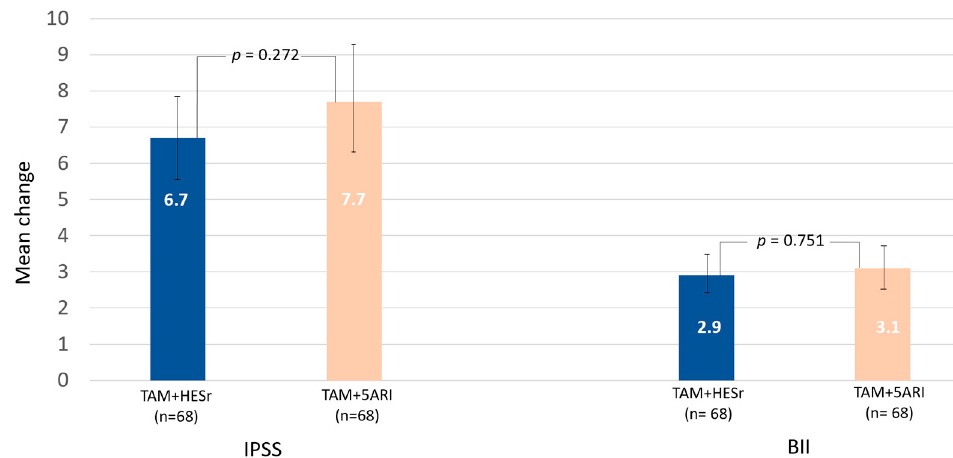
Figure 2. Mean IPSS and BII improvement (95% CI) in the two treatment groups after 6-month treatment (iterative matching sample). TAM: tamsulosin; 5ARI; 5-alpha-reductase inhibitor; HESr: hexanic extract of Serenoa repens; IPSS: International Prostate Symptom Score; BII: Benign Prostatic Hyperplasia Impact Index.